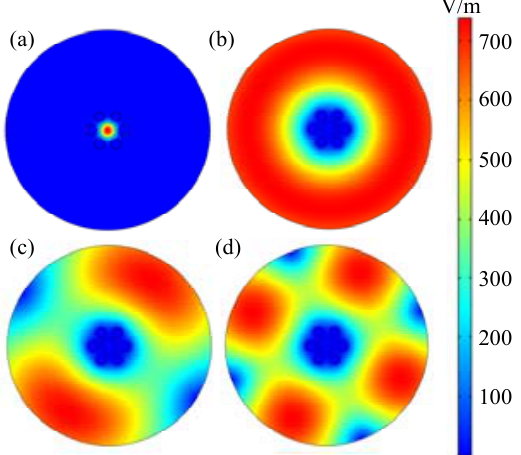
To understand the mode field distribution in optical fiber, simulation calculations